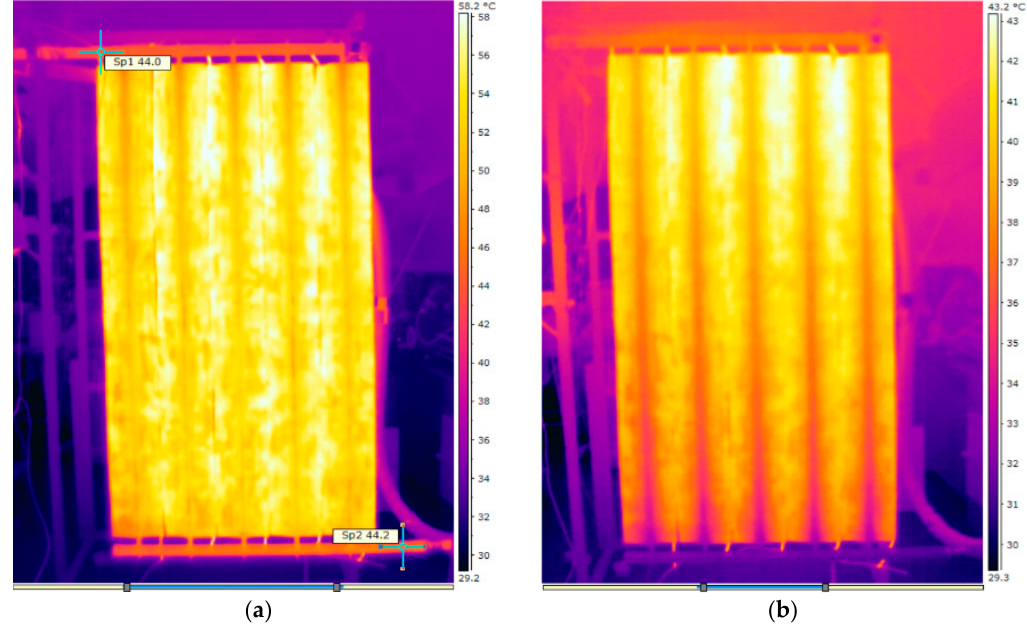
Figure 5. Infrared imagining testing of the absorber plate at the ( a ) Tp = Ti and ( b ) T _ p = f ( T _ i , VI , U _ L ).